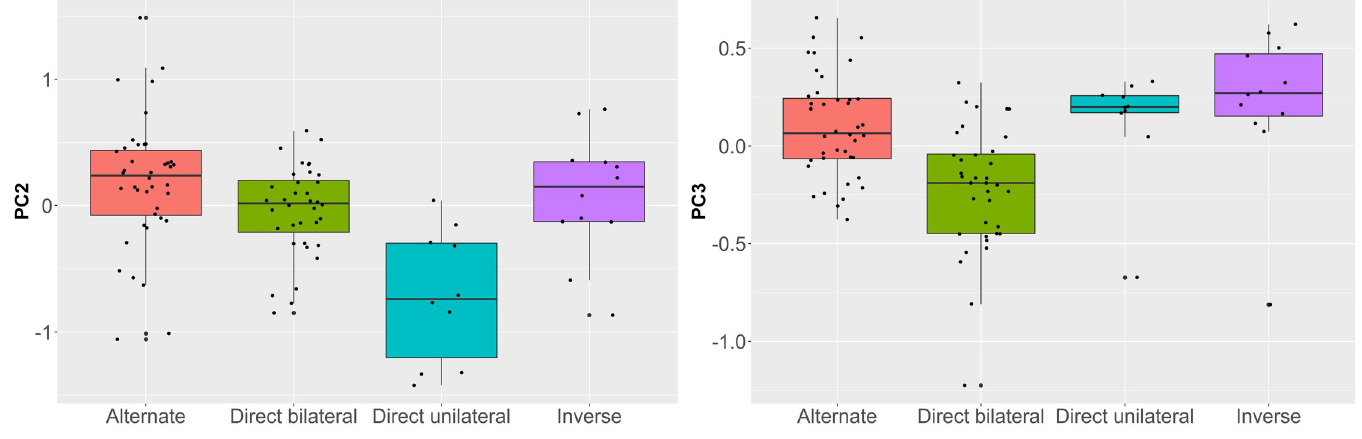
Fig 7. Boxplots with jittered points of PC2 (left) and PC3 (right) scores of retouched bladelets sorted according to retouch position.